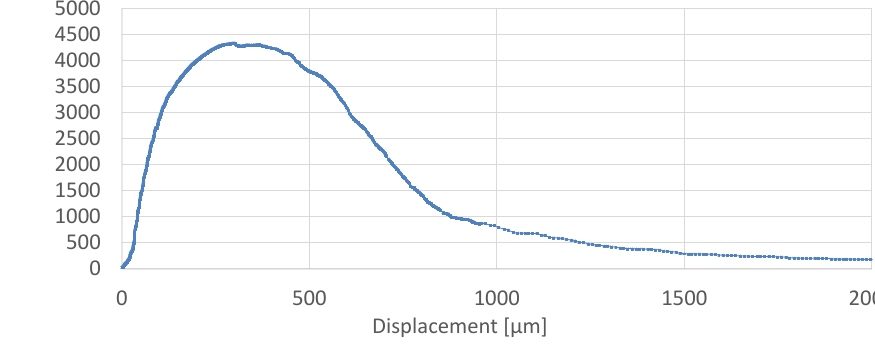
Figure 8. Force–displacement curve of large sample.